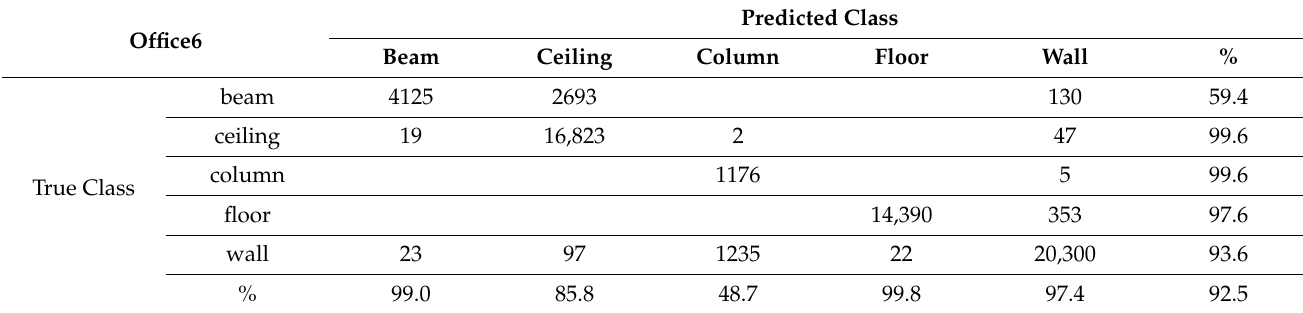
Table 3. Office_6 confusion matrix. The overall accuracy is 92.5%.